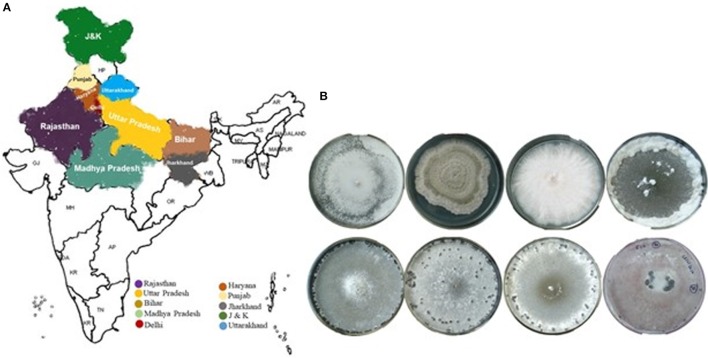
Geographic distribution map of isolates of Sclerotinia sclerotiorum from the 10 different states of India. There were 65 isolates collected from Brassica field of these states (A), and representative images of the S. sclerotiorum isolates with morphological variabilities (B).